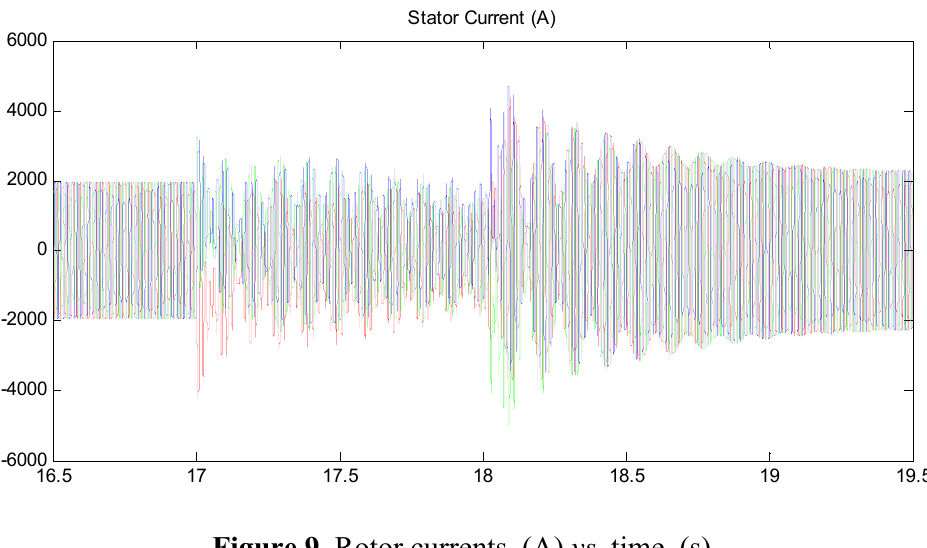
Figure 9. Rotor currents, (A) vs. time,